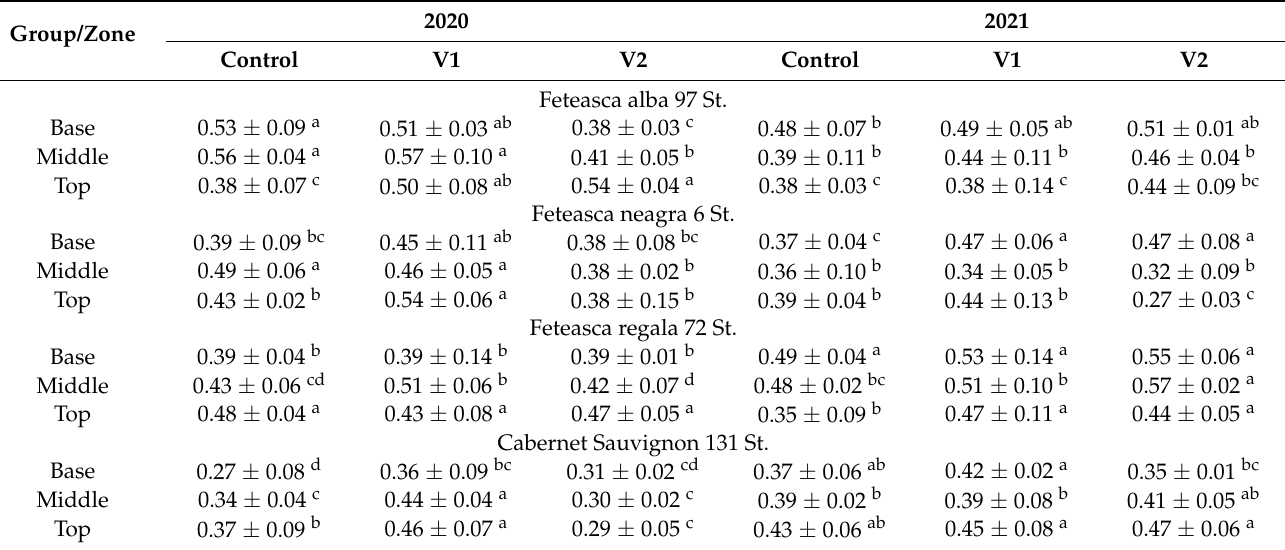
Table 2. The pith/wood ratio in the three zones of the cane (base, middle, top), at Feteasca alba